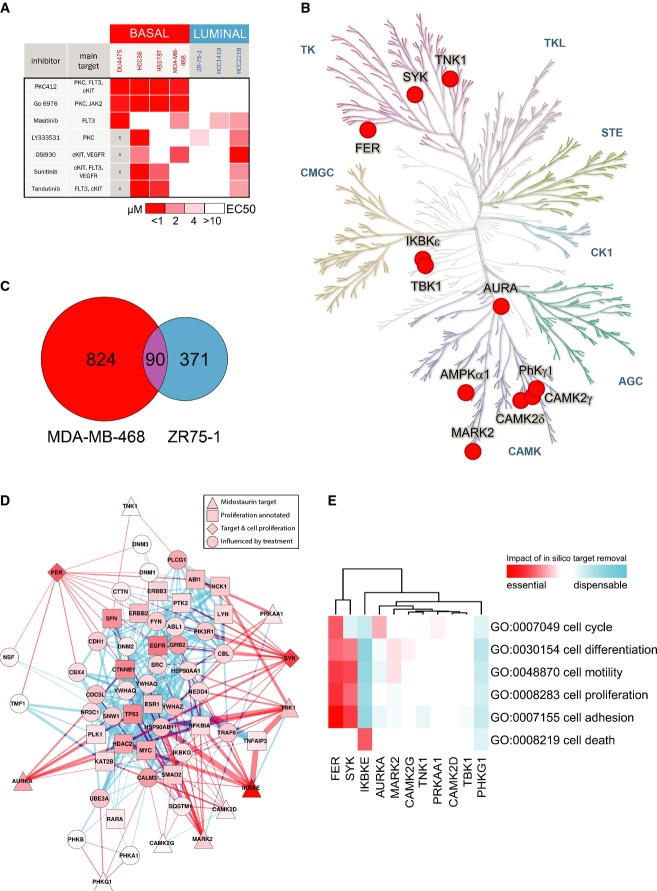
Chemical proteomics and computational modeling highlight SYK as a candidate critical node in basal-like breast cancer cells
A A panel of four basal-like and three luminal breast cancer cell lines were treated with the indicated inhibitors targeting canonical PKC412 targets. Red color shading indicates EC50. Grayed out boxes indicate cell line/drug combinations that were not tested.

B Immobilized PKC412 was used to identify binders in MDA-MB-468 cell lysates by mass spectrometry. Specific and non-specific binders were identified by competition with free PKC412 or the structurally similar but unspecific compound LY333531, respectively. Specific PKC412 binders were mapped onto the kinase tree (solid red circles).

C Venn diagram showing genes differentially expressed (> threefold) upon PKC412 (500 nM) treatment for 6 h in basal-like (MDA-MB-468, red) and luminal (ZR75-1, blue) breast cancer cell lines.

D Most significantly perturbed protein–protein interaction subnetwork (P < 0.005) upon PKC412 treatment. Red lines indicate direct interactions with a PKC412 target. Blue lines indicate indirect interactions. Edge thickness indicates simultaneous regulation upon PKC412 treatment (see Materials and Methods).

E Heatmap showing the impact of the individual PKC412 targets on selected GO terms (see also Supplementary Table S3). Red represents reduced association with the GO term, therefore indicating potentially essential targets. Blue represents dispensable targets.